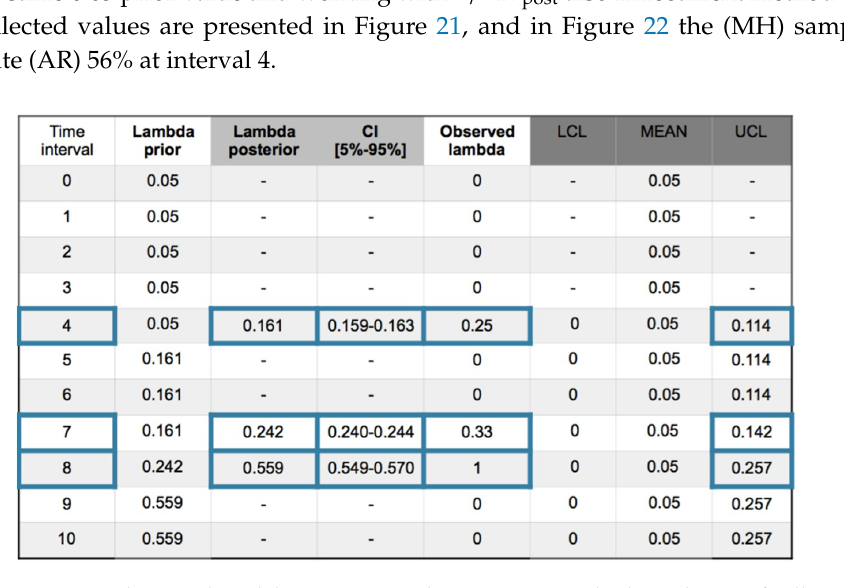
Figure 21. Exponential–normal model. Recurrent with mean prior method. Evolution of collected (ic’s) and safety barrier fails in 10 intervals. Confidence interval (CI) [5%–95%]. Out of limits framed blue.